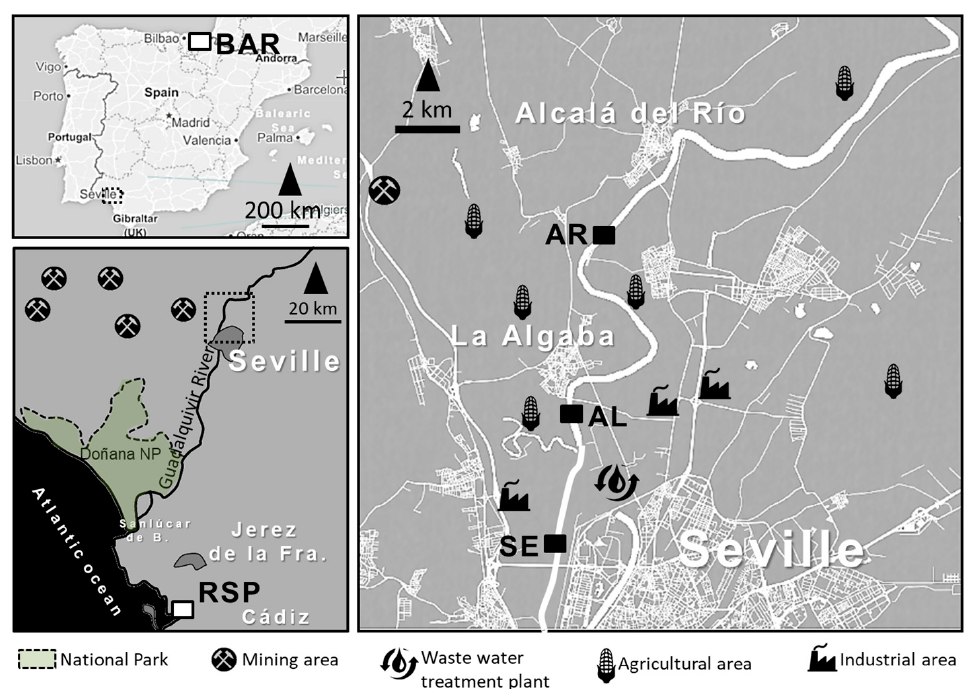
Figure 1. Location of sampling stations in the Guadalquivir River: Alcalá del Río town (AR), Algaba (AL) municipality, and Seville (SE); and controls from Río de San Pedro (RSP) in Cádiz, and Barazar (BAR) in Bilbao.